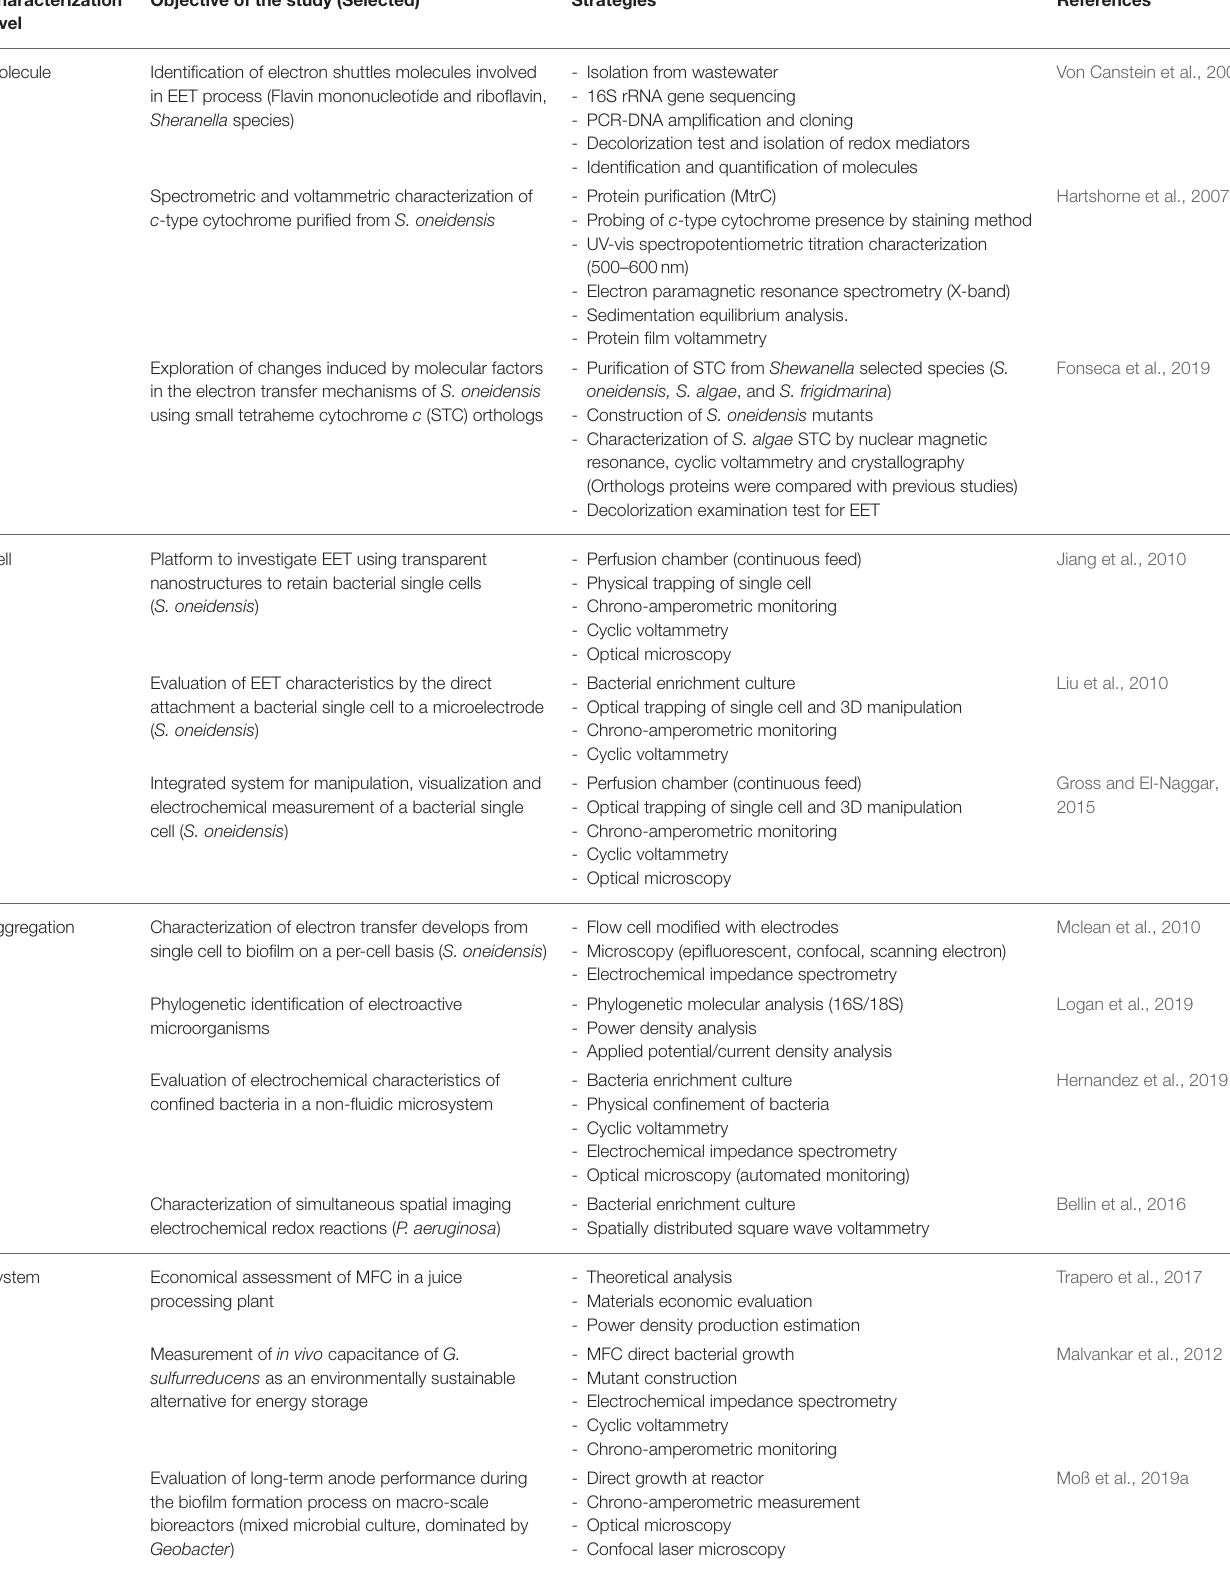
TABLE 2 | Strategies used for characterization at different resolution levels. Characterization